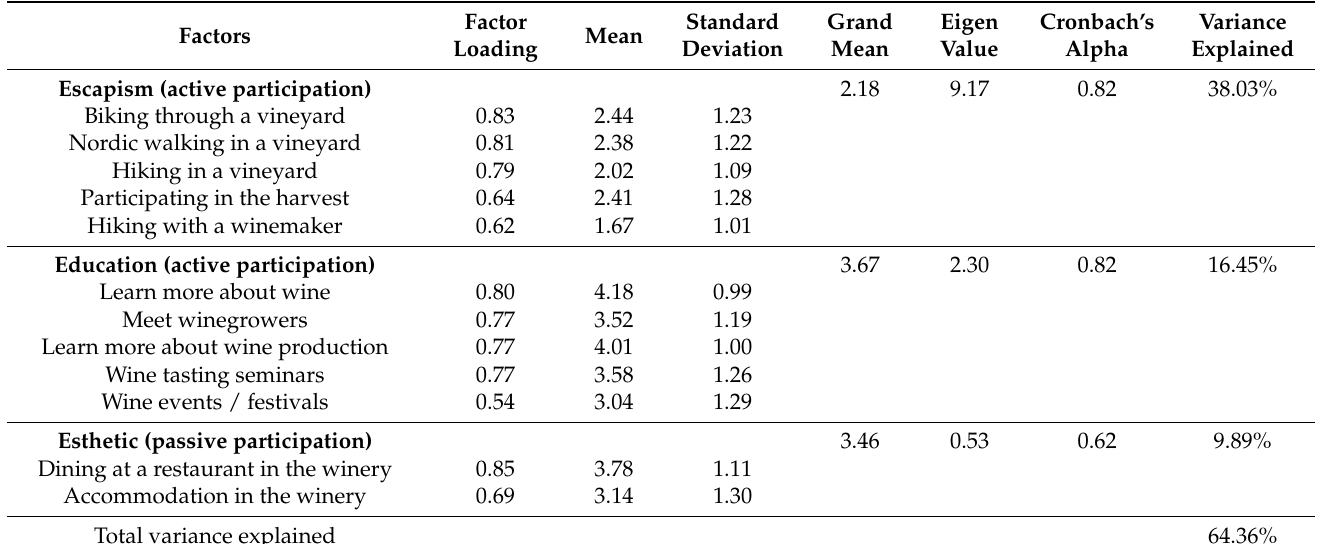
Table 4. Results of the factor analysis for expectations of experiences with respect to wine-related activities in